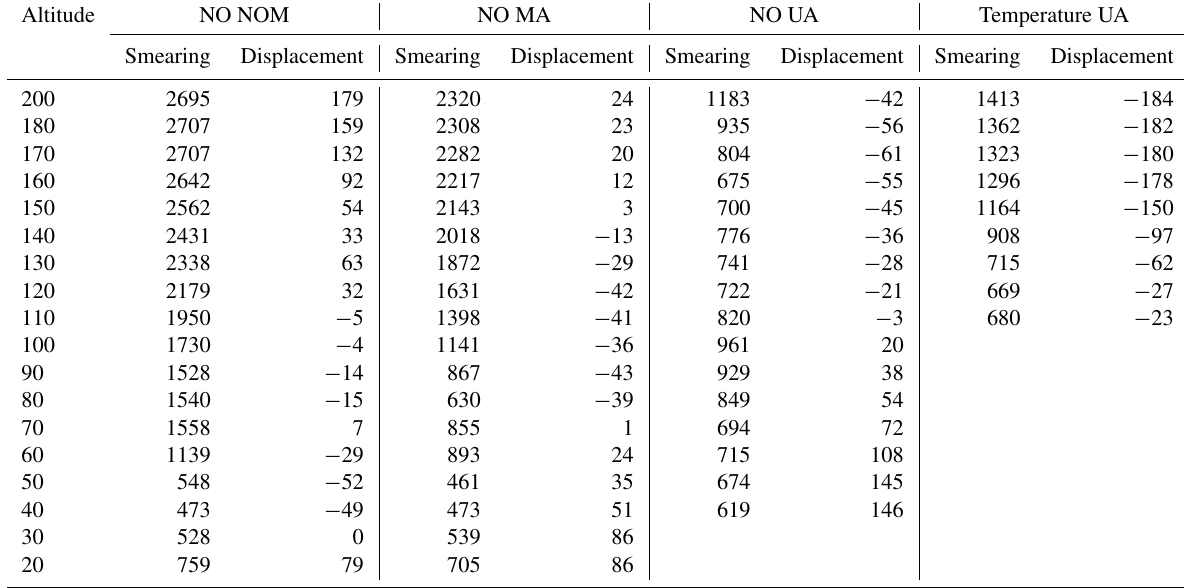
Table 4. Horizontal-information distribution of NO and temperature at selected altitudes. All distances are given in